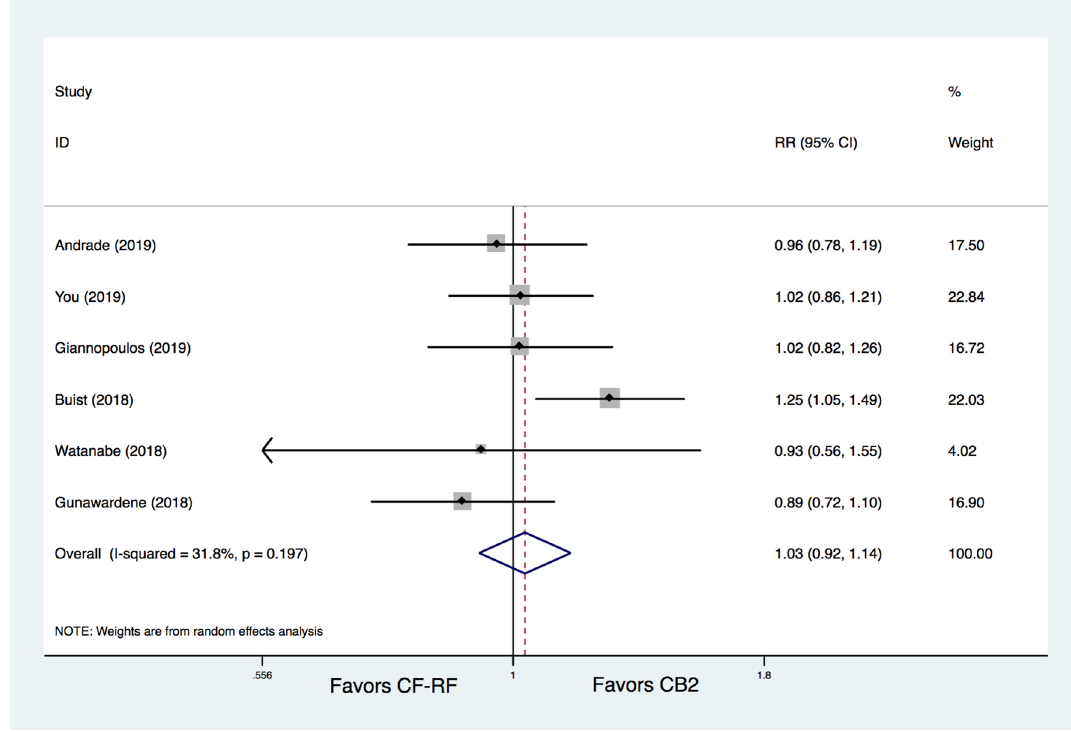
Figure 2. Meta-analysis for the outcome of freedom from AT. CF-RF = contact force radiofrequency ablation; CB2 = cryoballoon ablation (CBA) with second-generation cryoballoon; RR = relative